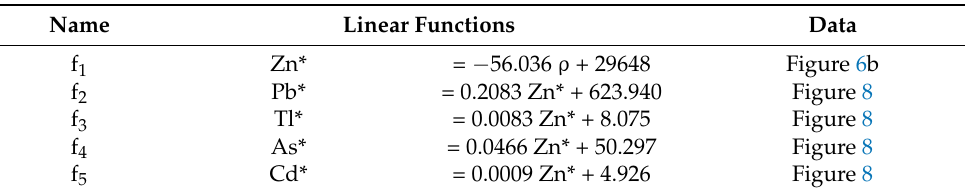
Table 3. Linear functions used in the estimation of the metal(oid) contents along borehole S3. The inverted resistivity ( ρ ) is obtained from the ERT survey, whereas the notation “*” indicates the